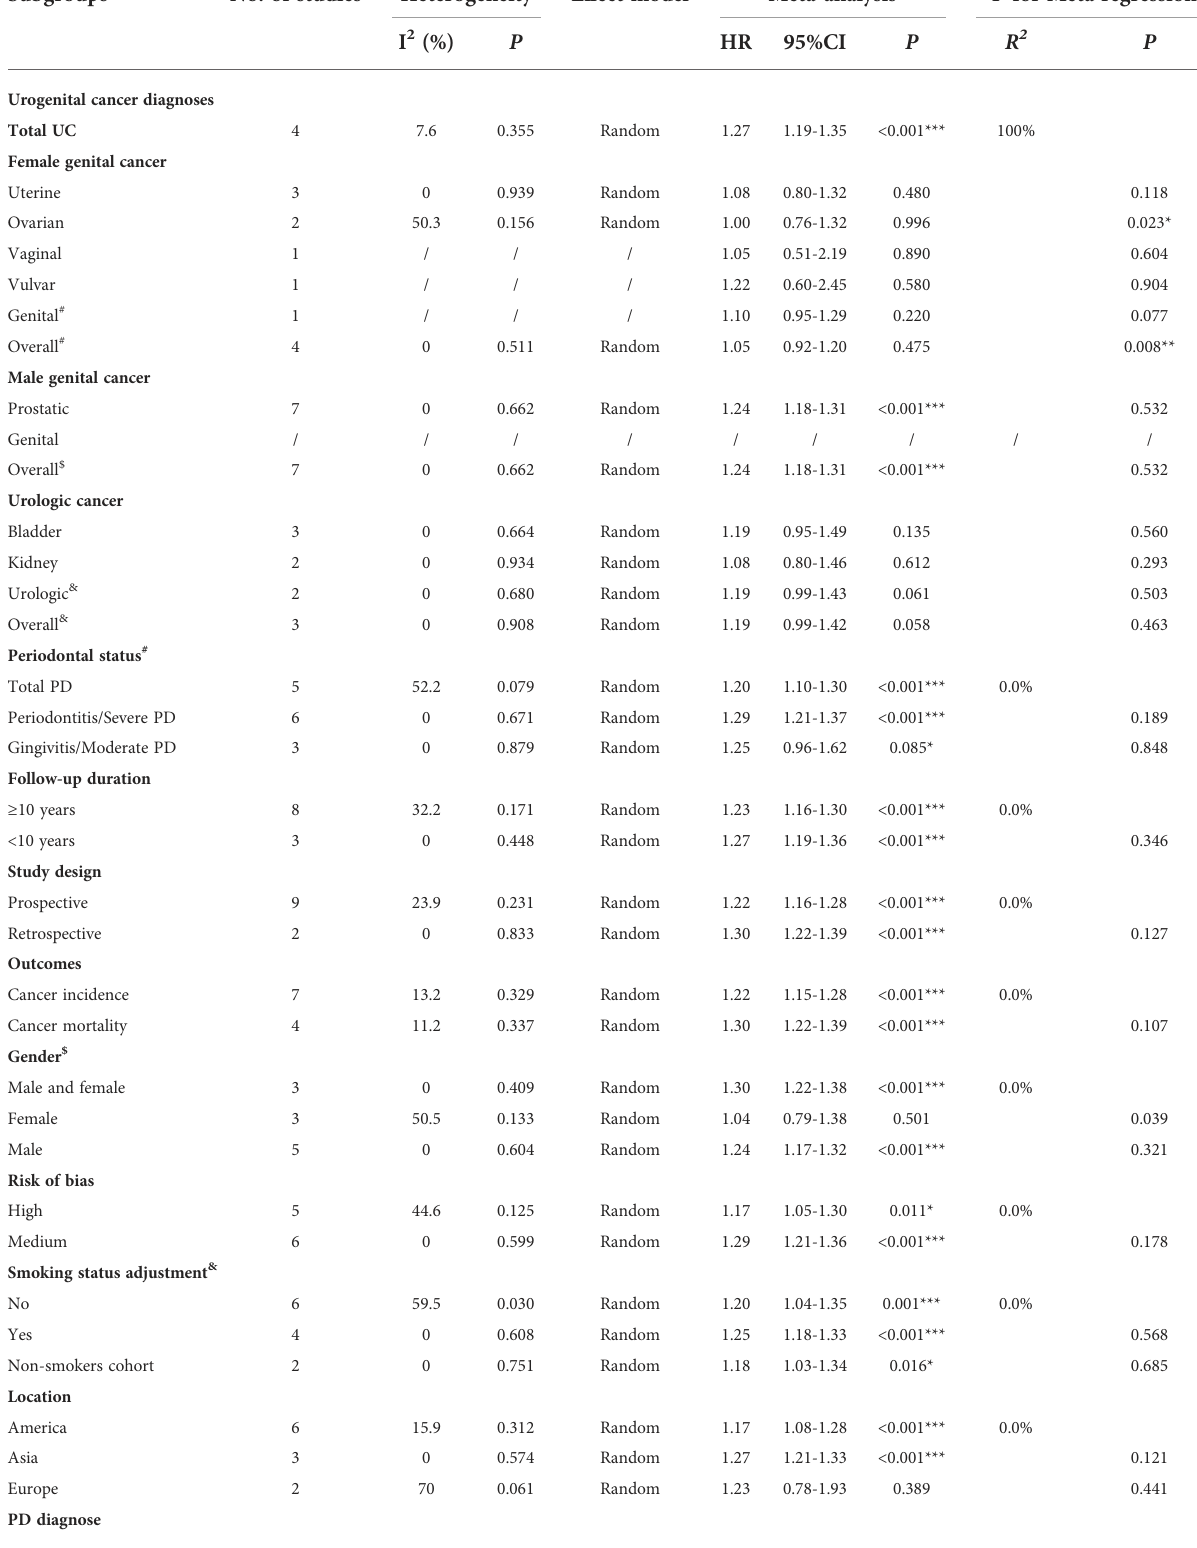
TABLE 3 Results of subgroup analyses and meta-regression.